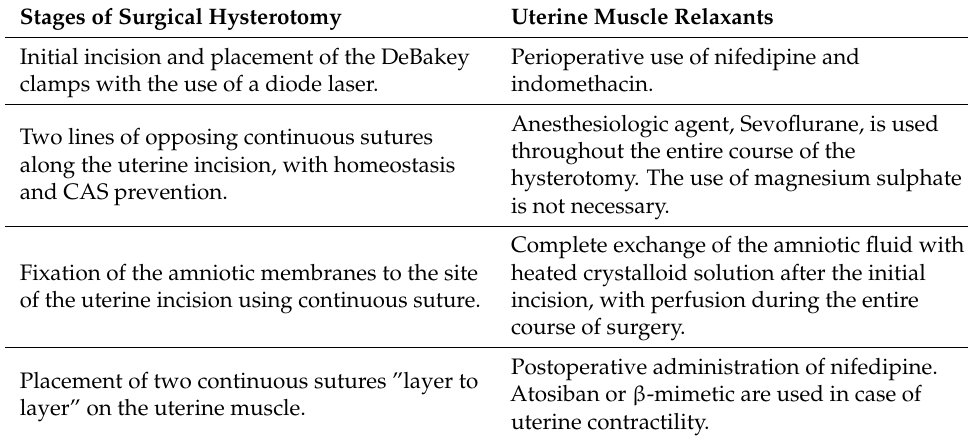
Table 5. MgFTCH protocol–key points for